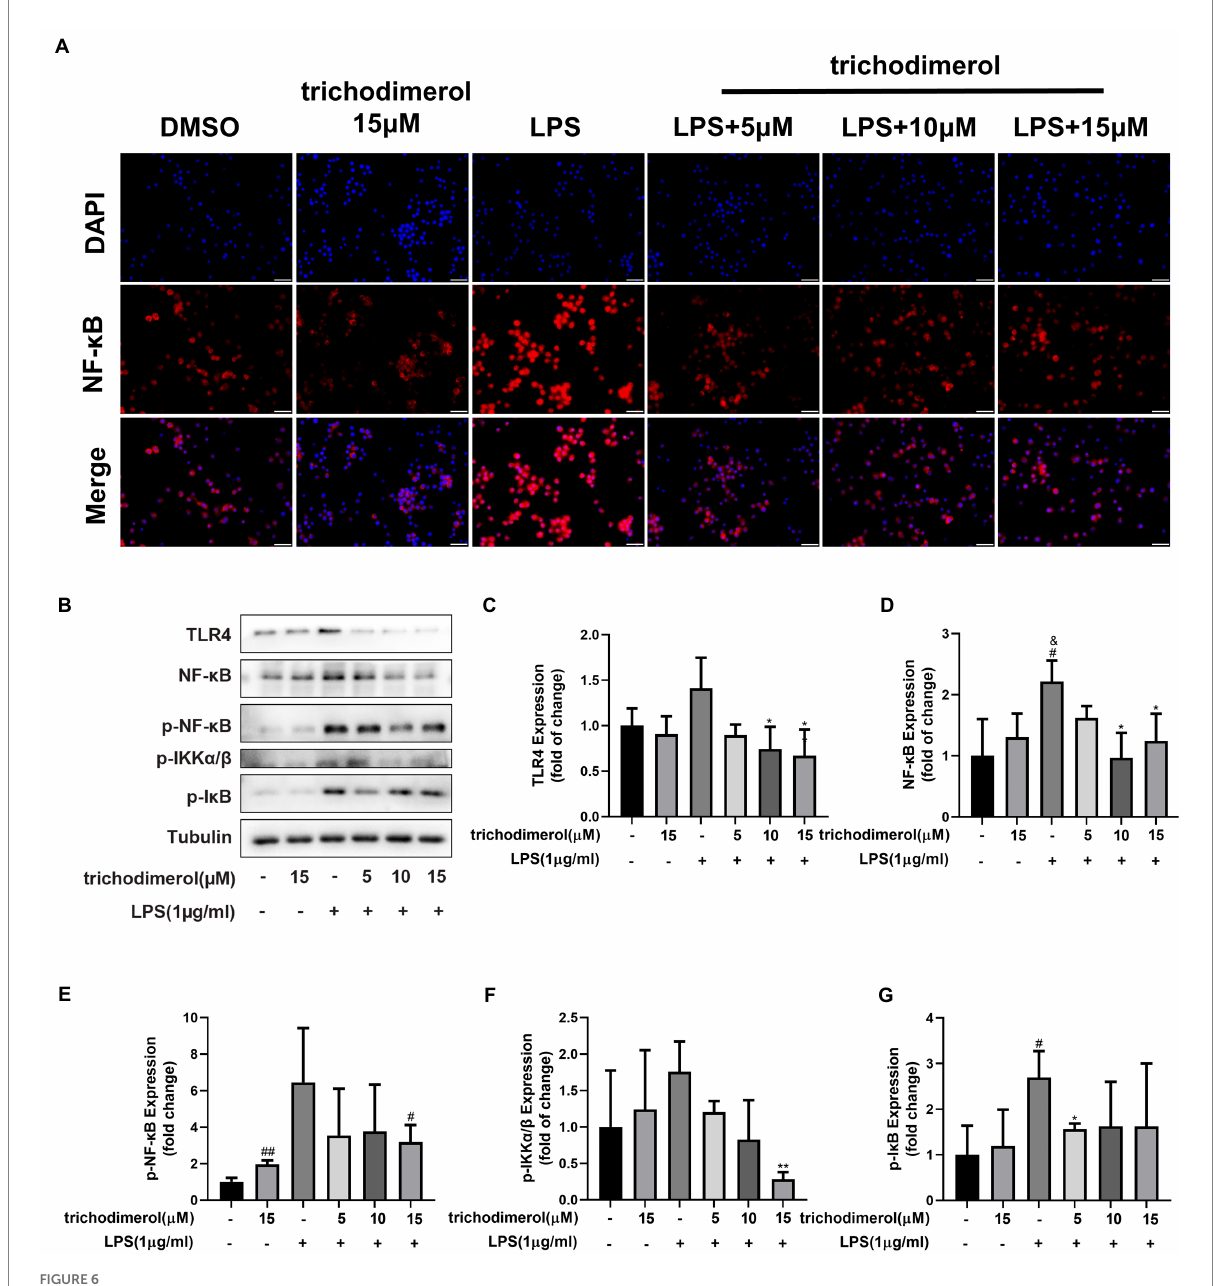
FIGURE 6 The effect of trichodimerol on the NF- κ B pathway. (A) Nuclear translocation of RAW264.7 macrophages induced by LPS after 12 h of trichodimerol treatment. Red fluorescence represents the NF- κ B signal, blue fluorescence represents the nucleus, white stripe = 50 μ m. (B) The protein expression of TLR4, NF- κ B, p-NF- κ B, p-IKK α / β , and p-I κ B in RAW264.7 macrophages treated with different concentrations; Tubulin was used as an internal reference. (C) Quantitative statistical results of TLR4 protein expression. (D) Quantitative statistical results of the protein expression of NF- κ B. (E) Quantitative statistical results of the protein expression of p-NF- κ B. (F) Quantitative statistical results of the protein expression of p-IKK α / β . (G) Quantitative statistical results of the protein expression of p-I κ B. All data are expressed as the mean ± SD. # p < 0.05, ## p < 0.01, compared with the DMSO group. & p < 0.05, compared with the trichodimerol 15 μ M group. * p < 0.05, ** p < 0.01, compared with the LPS group.